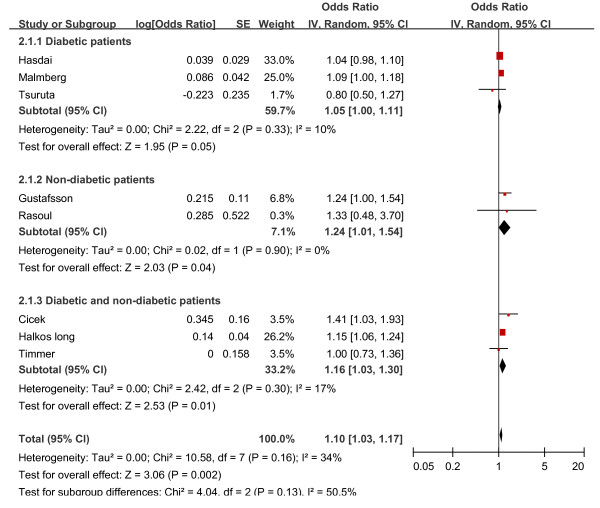
Adjusted mortality risk ratio for elevated HbA1c level.